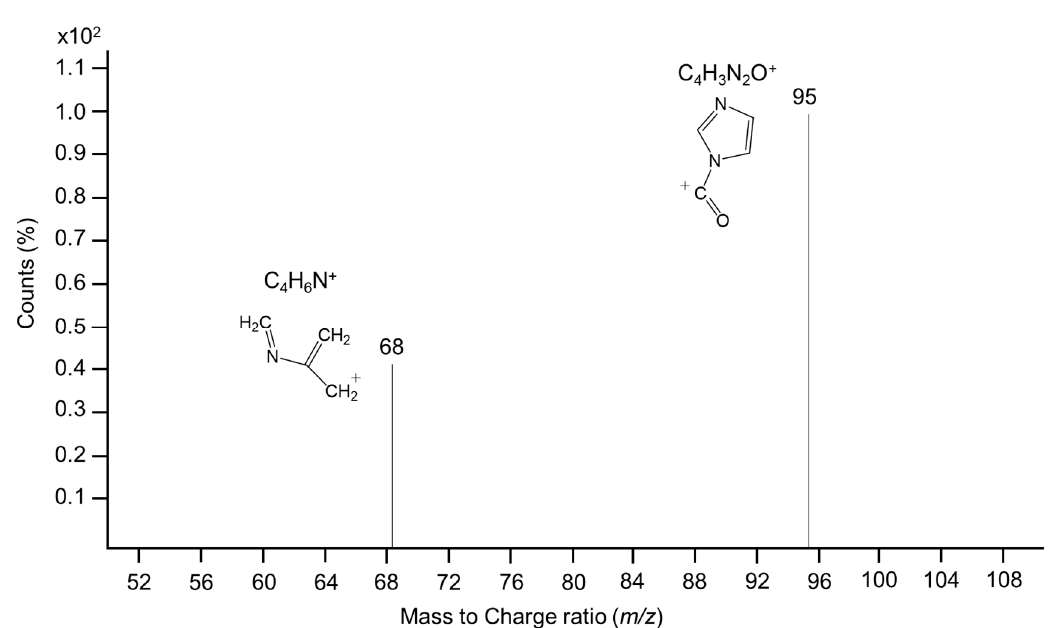
Figure 4. MS/MS spectra of carbethoxyhercynine m / z 270.28.